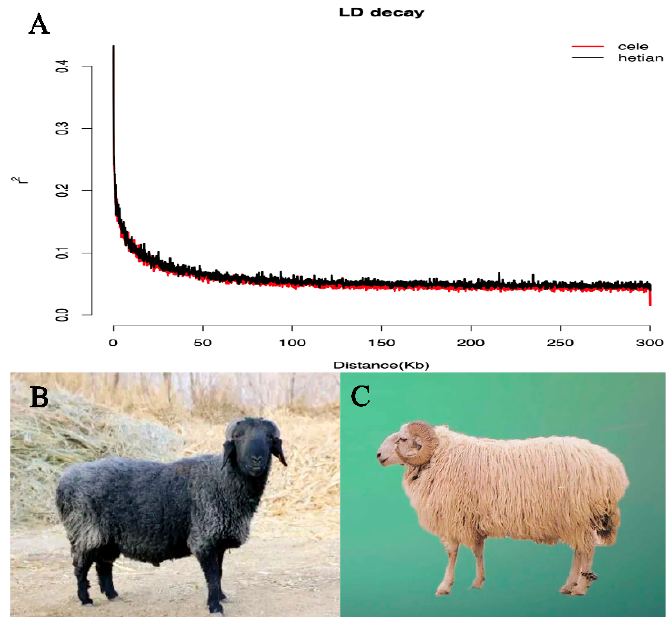
Figure 1. ( A ): The decline curve of linkage disequilibrium (LD) between Hetian and Cele black sheep. ( B ): Cele black sheep. ( C ): Hetian sheep.